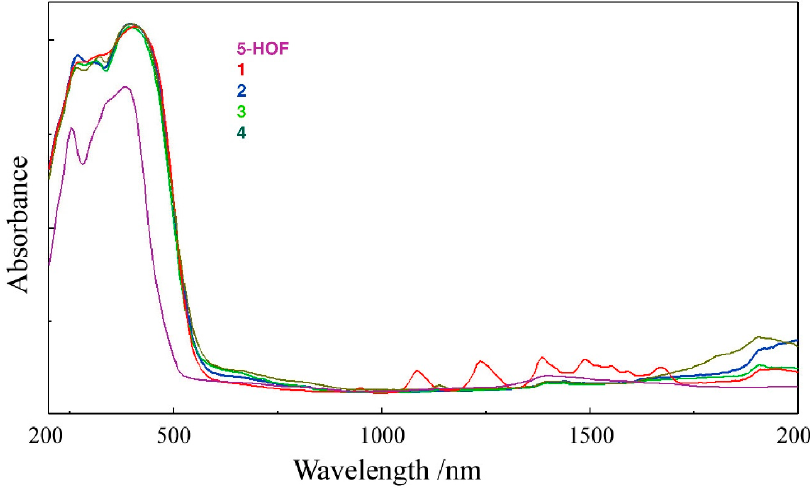
Figure 2. Electronic spectra of the ligand and the complexes (recorded on solid probes).